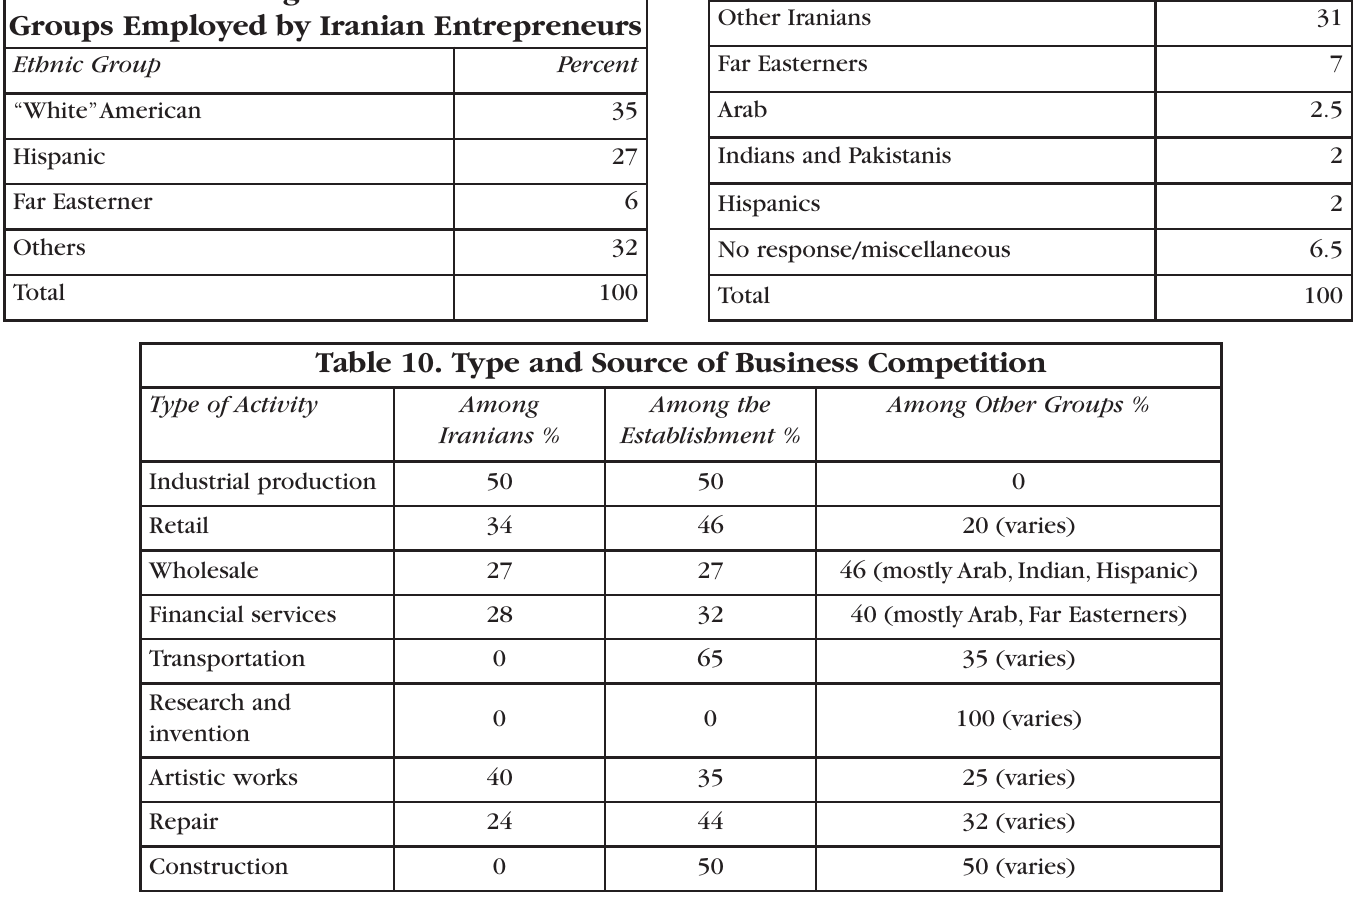
Table 8. Percentage of Ethnic and Racial